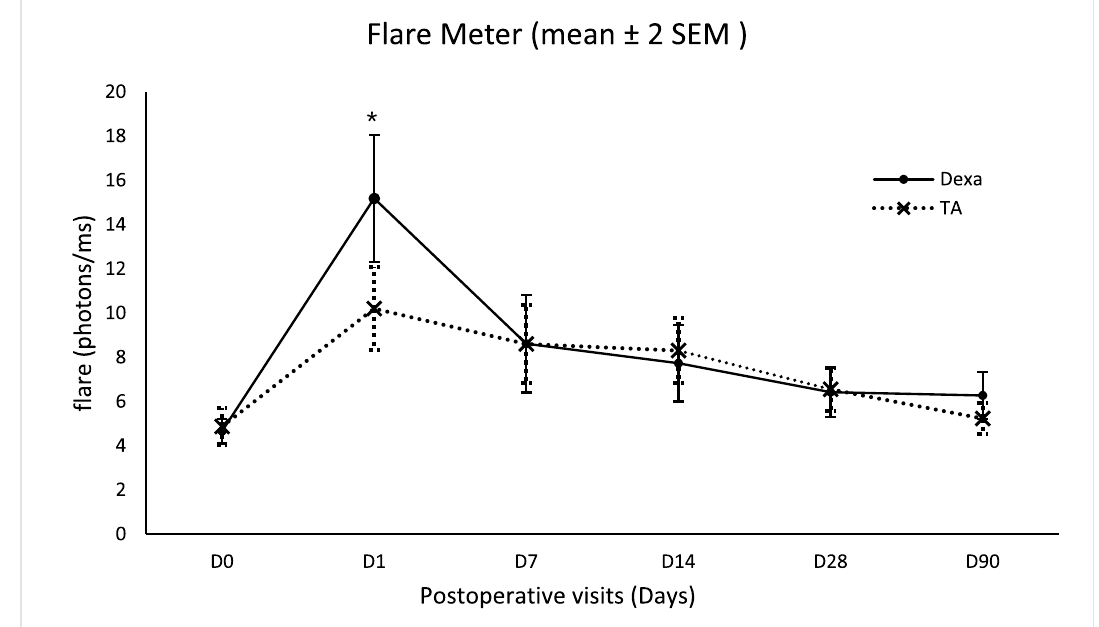
Figure 4. Mean anterior chamber flare ± 2 SEM (photons/ms) from laser flare-cell meter at each study visit. The mean flare of TA group was significantly lower than Dexa group on post operative day 1 (mean difference 4.98; 95% CI 1.59, 8.36; * p = 0.004).